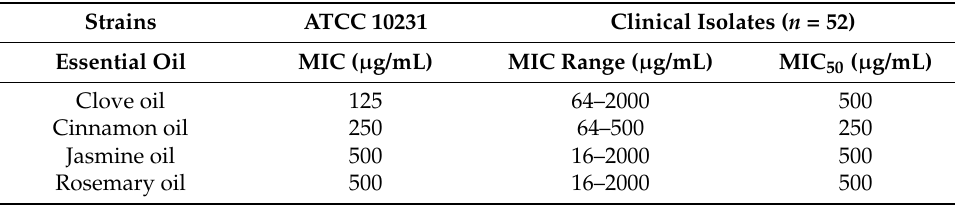
Table 1. The MIC of essential oils against clinical strains of C. albicans .